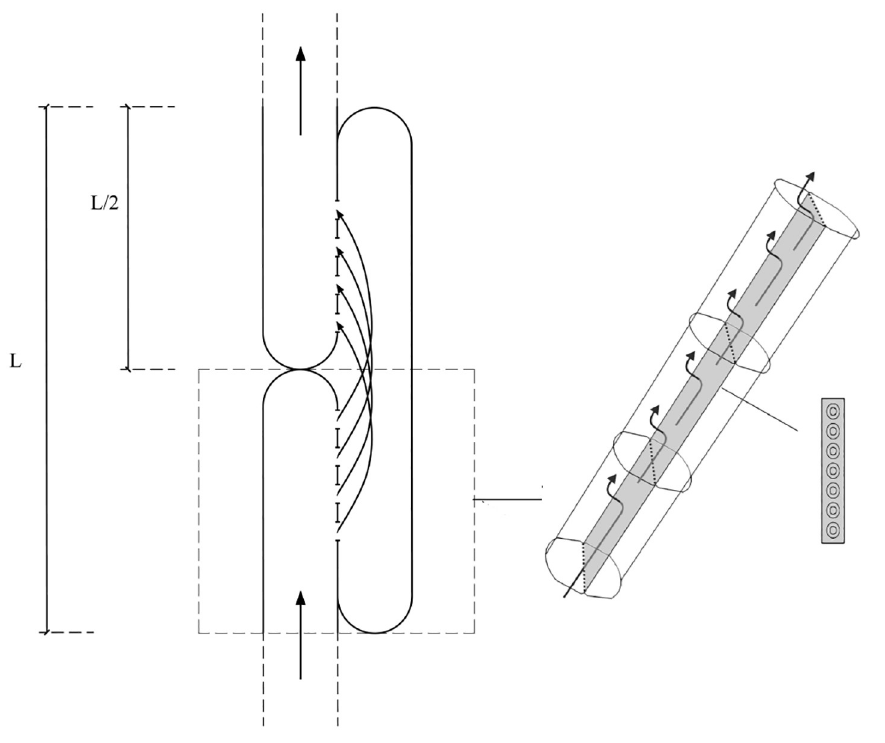
Fig 7. Model of tracheid water flow.